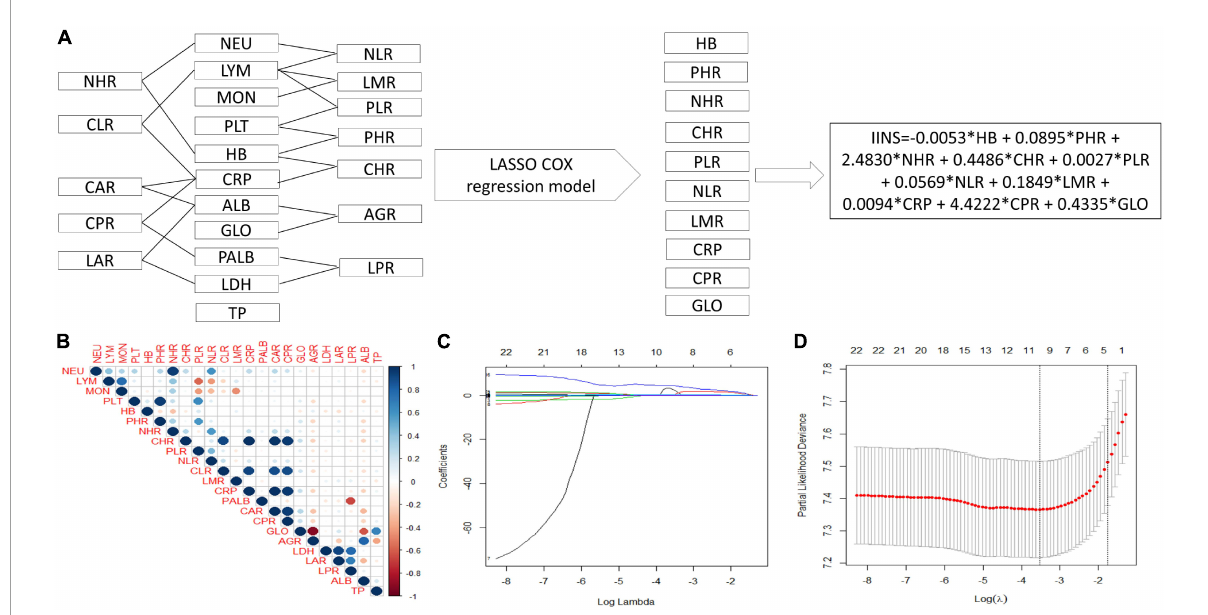
FIGURE2 Process diagram for integrative inflammatory and nutritional score (IINS) construction and risk stratification. IINS constructed with 10 indicators out of 23 variables by least absolute shrinkage and selection operator (LASSO) Cox proportional hazards (PH) regression model (A) . A correlation matrix is represented regarding 23 indicators (B) . LASSO coefficient profiles of the 23 indicators (C) . 10-fold cross–validation for tuning parameter selection in the LASSO model (D)